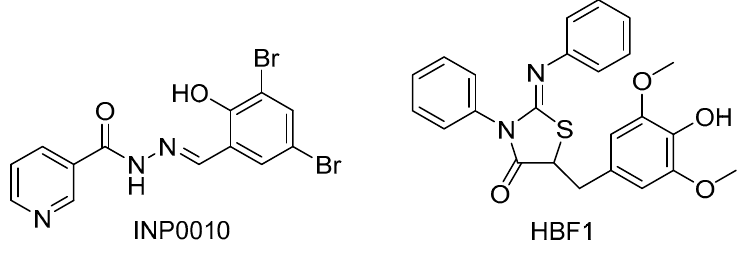
Figure 13. Structure of SA INP0010 and thiazolidinone HBF1.